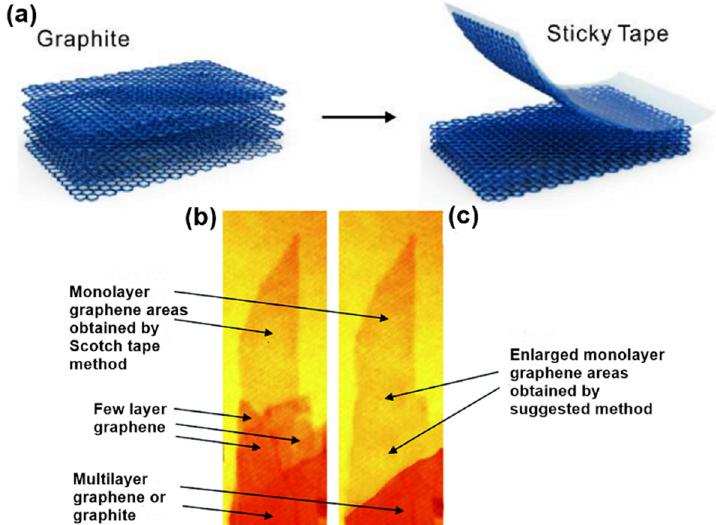
Figure 1. ( a ) Schematic illustration of the mechanical exfoliation of monolayer grapheme [49]. Optical images of monolayer graphene ( b ) as-prepared by scotch tape method and ( c ) as enlarged using Shmavonyan suggested method. Reproduced with permission from [46]. Copyright 2013 National Academy of Sciences of Armenia.